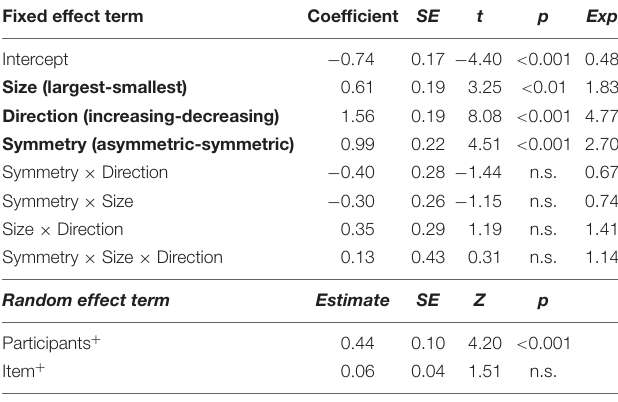
TABLE 4 | Fixed effects analysis for experiment 2.